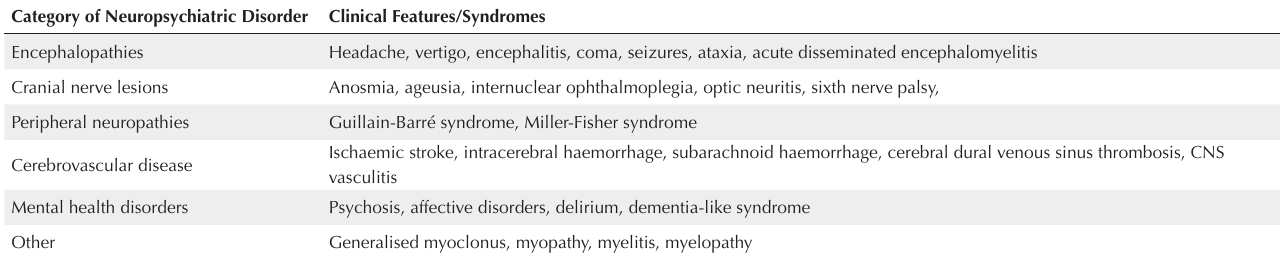
Table 1 . Summary of Neuropsychiatric Manifestations and Sequelae of COVID-19 Category of Neuropsychiatric Disorder Clinical